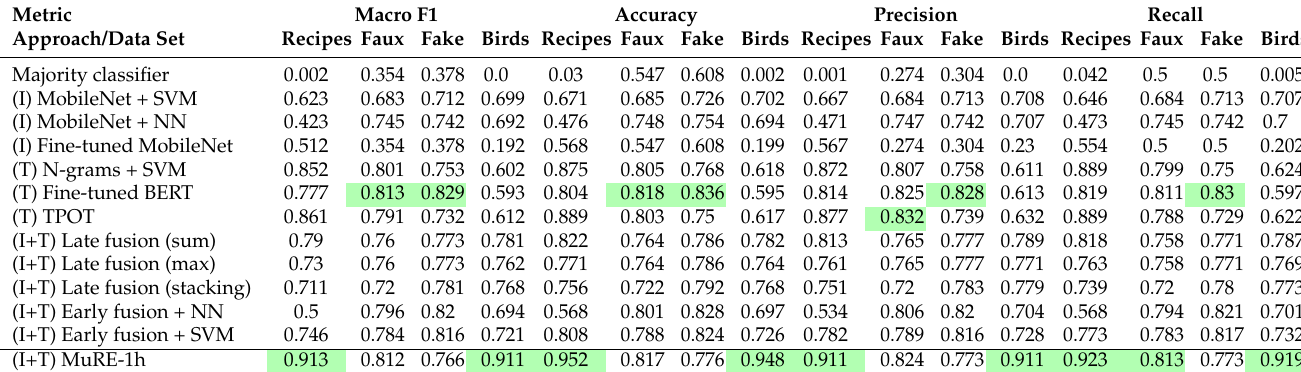
Table 3. Classification results—10 fold cross validation, same seed for all methods (420). Green cells denote either first or second rank for a given dataset (I = images, T = texts).